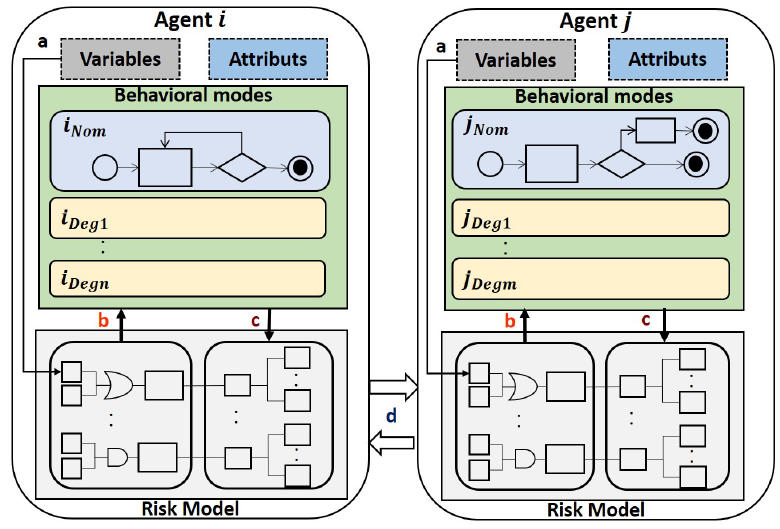
Figure 8. Generic Dynamic Agent-Based Risk Model (GDABM).